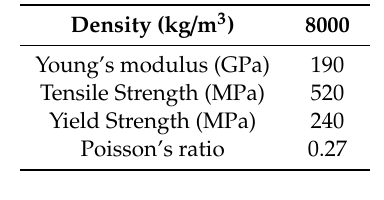
Table 2. Properties of STS304 stainless steel.